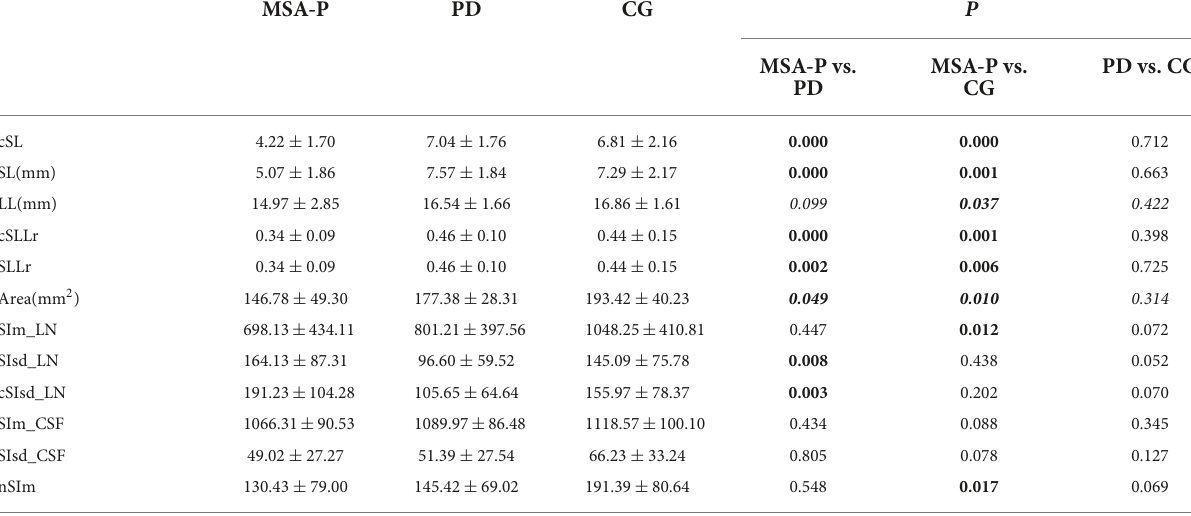
TABLE 3 Comparison of morphological and signal measurement among different group (mean ± standard